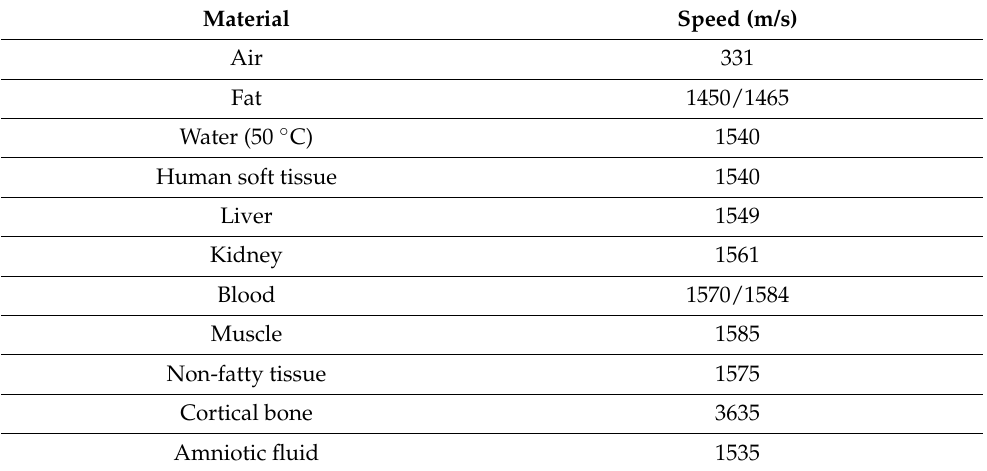
Table 3. Speed of sound in different substances or